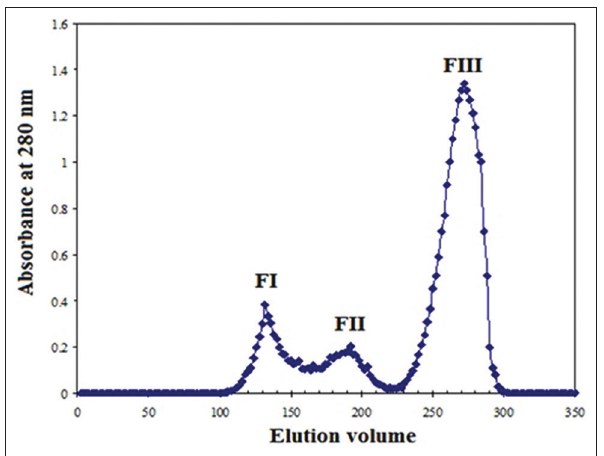
Figure-1: Purification profile of hydatid cyst fluid antigen on Sephacryl S 300 column chromatography.